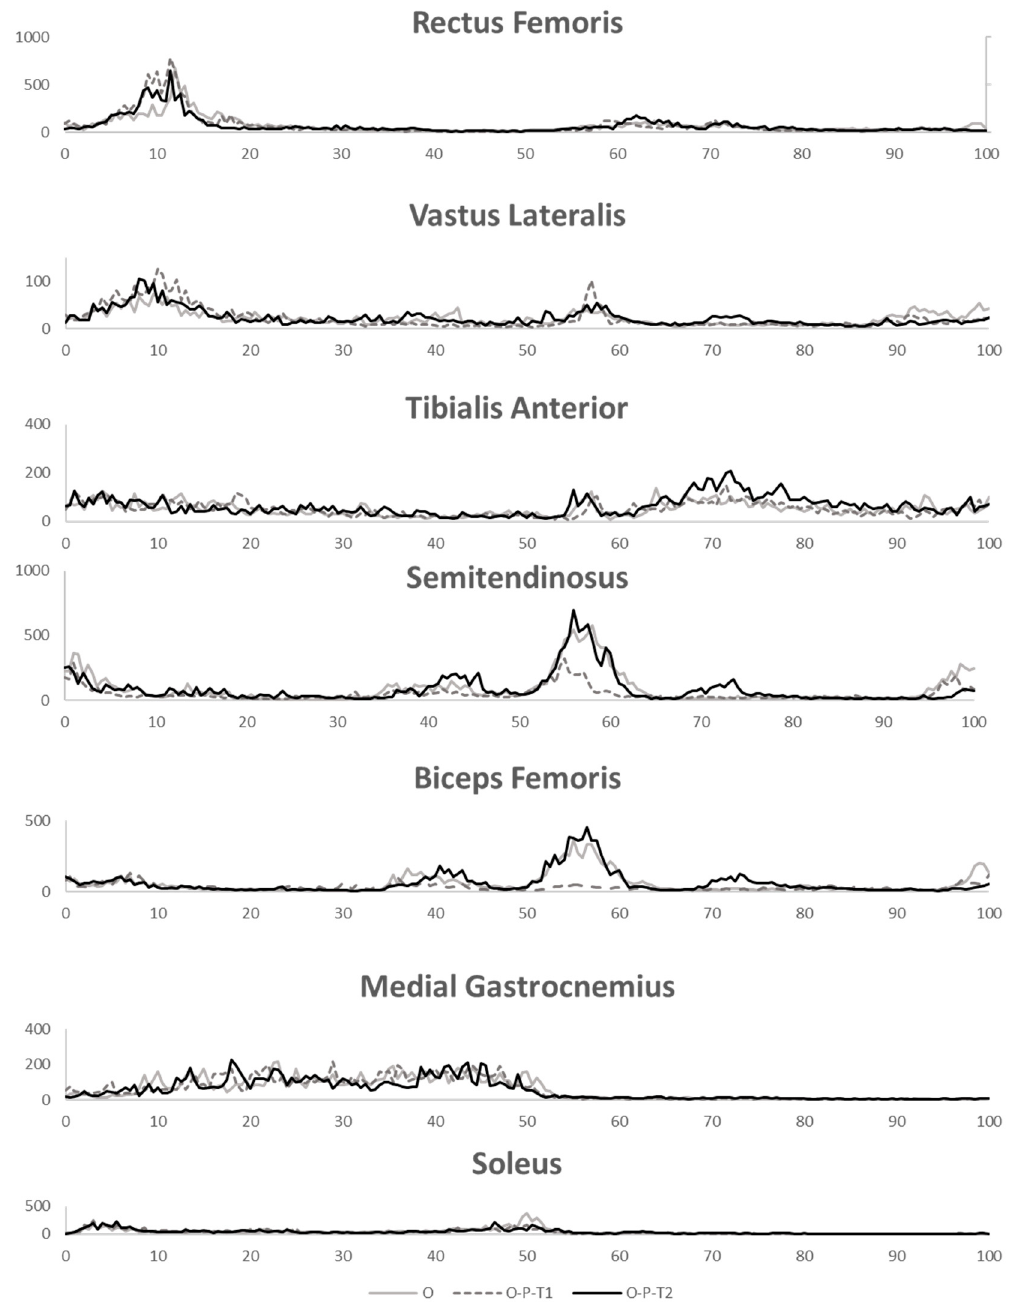
Figure 6. Surface EMG of seven lower limb muscles of one representative subject across conditions of unperturbed (O; gray), early perturbation of obstacle to platform (O-P-T1, dashed line) and late perturbation (O-P-T2, black line) conditions.